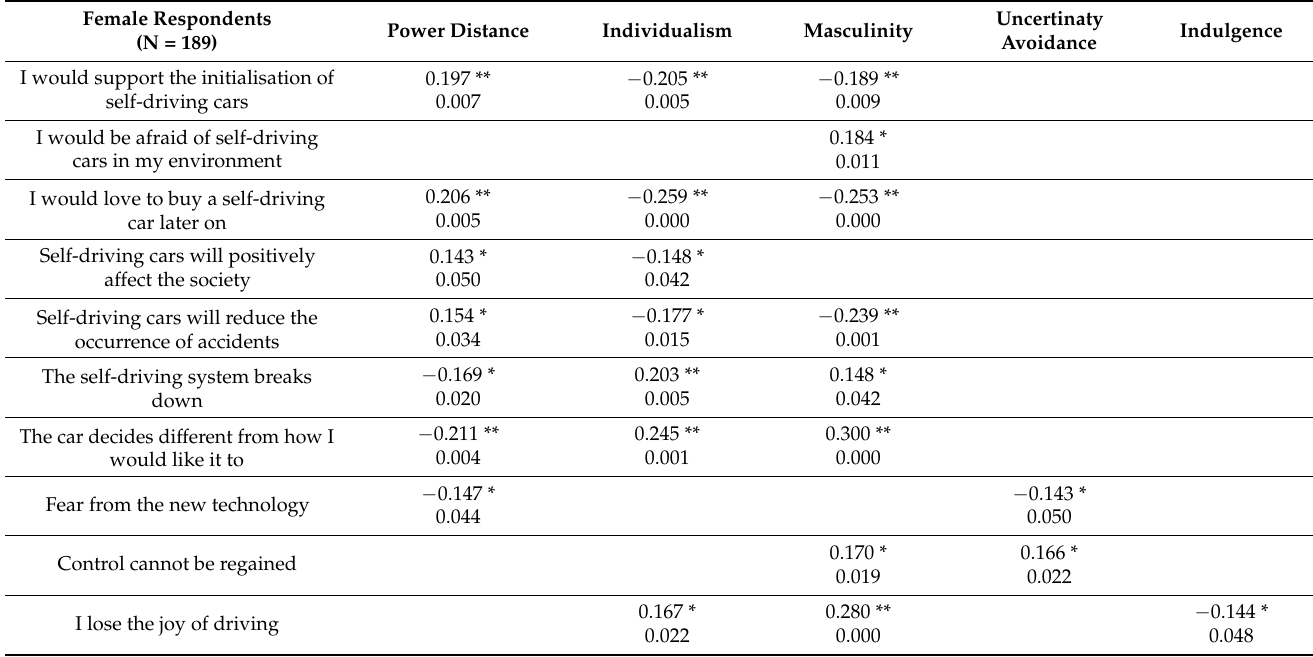
Table 6. The significant relations of cultural dimensions and perceptions of female respondents in the